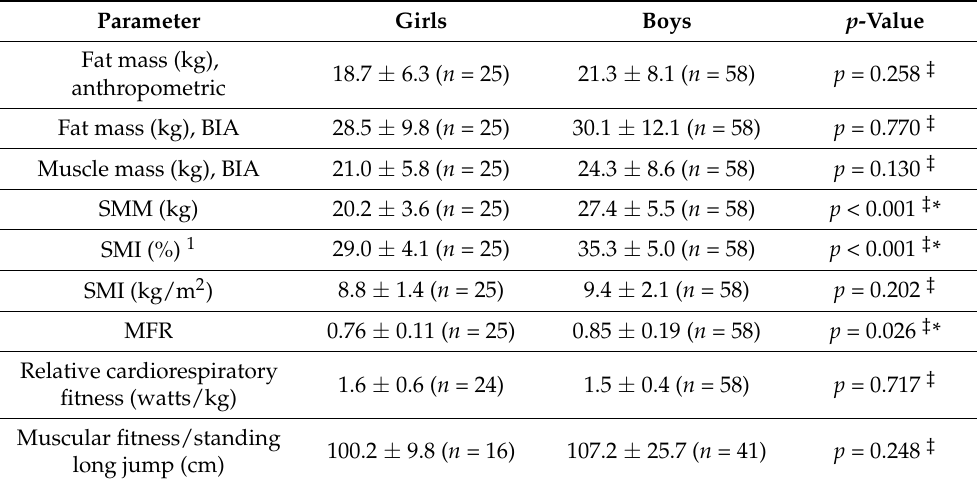
Table A4. SMM, SMI, MFR, cardiorespiratory fitness, and standing long jump of the group of sarcopenia present in girls and